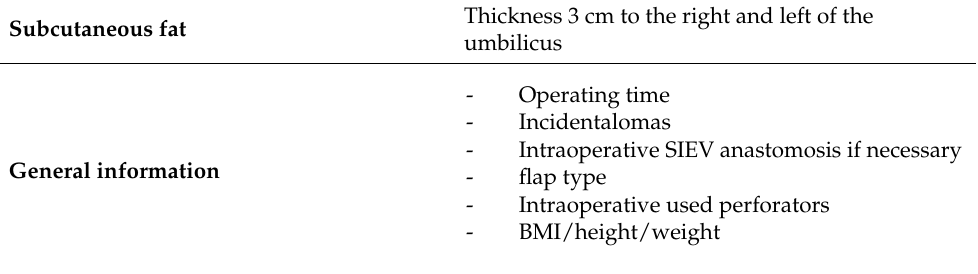
Thickness 3 cm to the right and left of